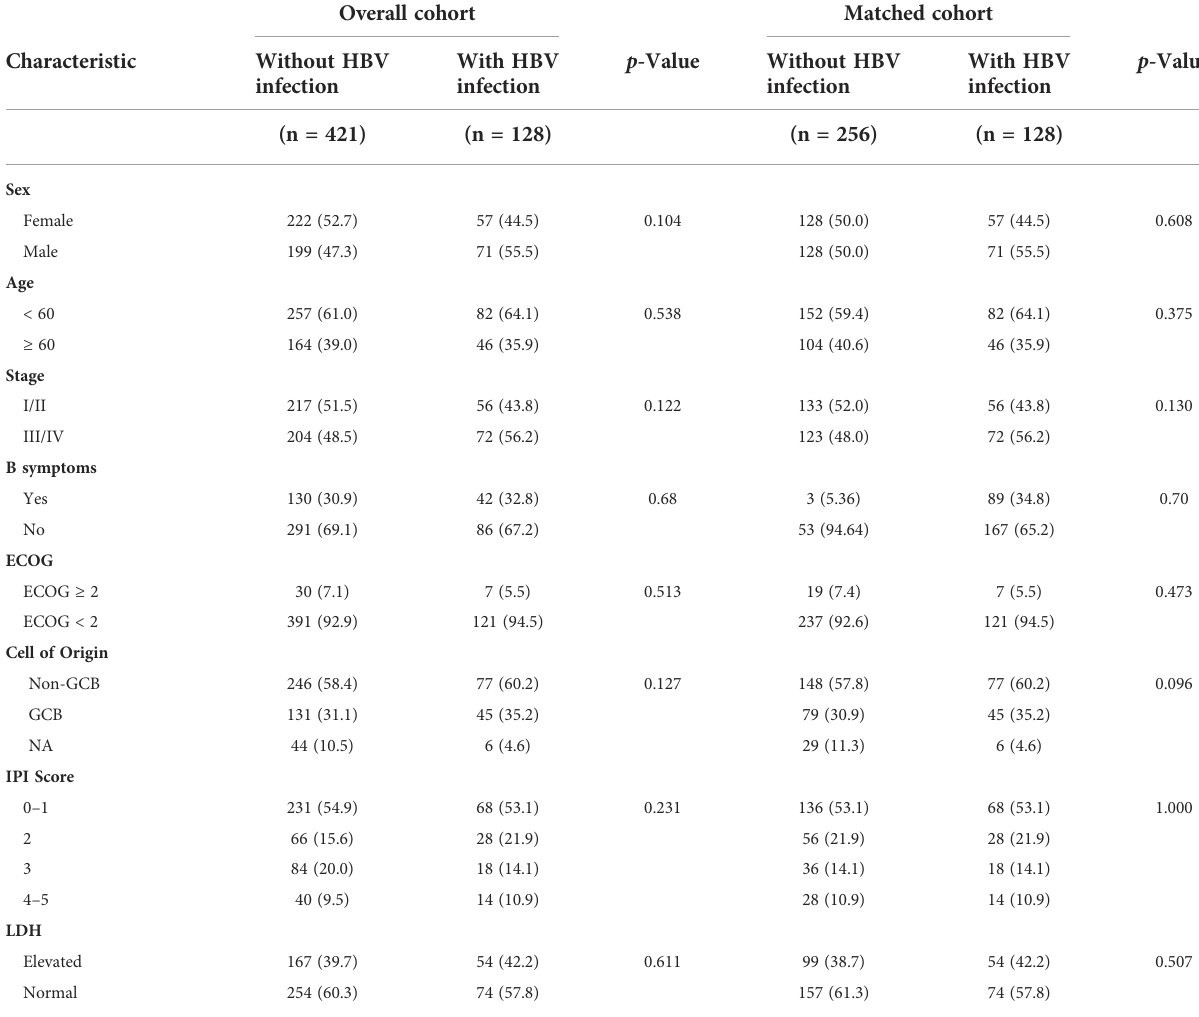
TABLE 2 Baseline characteristics of patients with and without HBV infection before and after Propensity Score